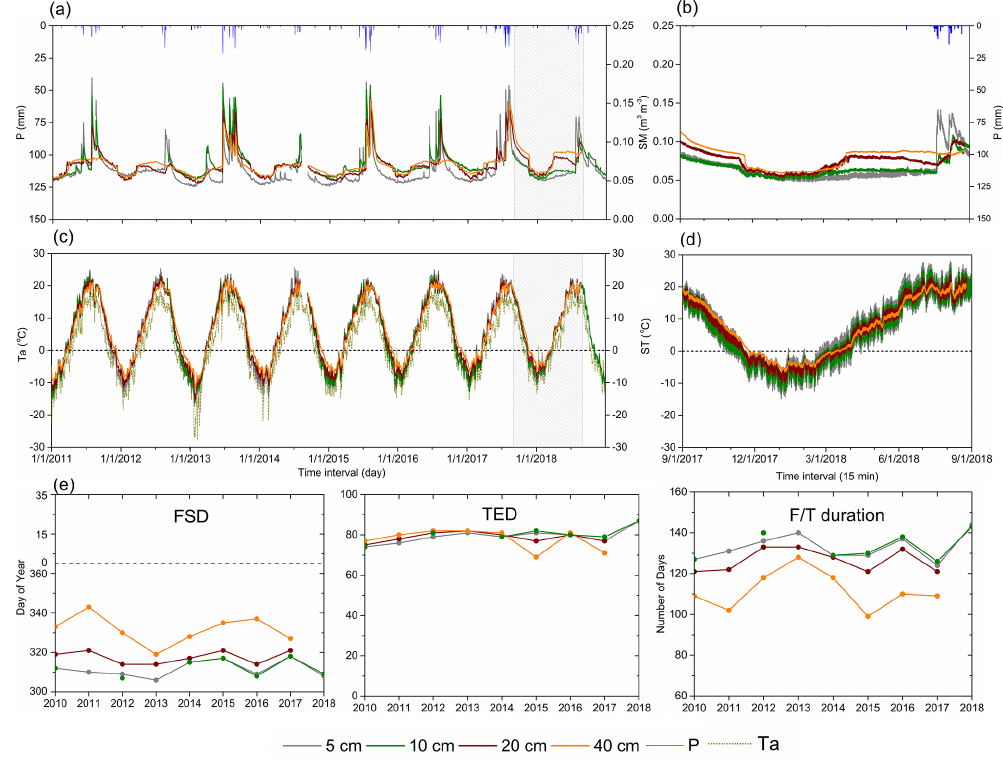
Figure 8. Time series of upscaled daily (a) SM ups and (c) ST ups at depths of 5, 10, 20, and 40cm for the Shiquanhe network between January 2011 and December 2018. The subplots highlight the time series of the upscaled (b) SM ups and (d) ST ups with intervals of 15min between 1 September 2017 and 31 August 2018. (e) Annual variations in FSD, TED, and F/T duration at 5, 10, 20, and 40cm depths. The time series of daily precipitation and air temperature are shown in panels (a) and (c) as well.